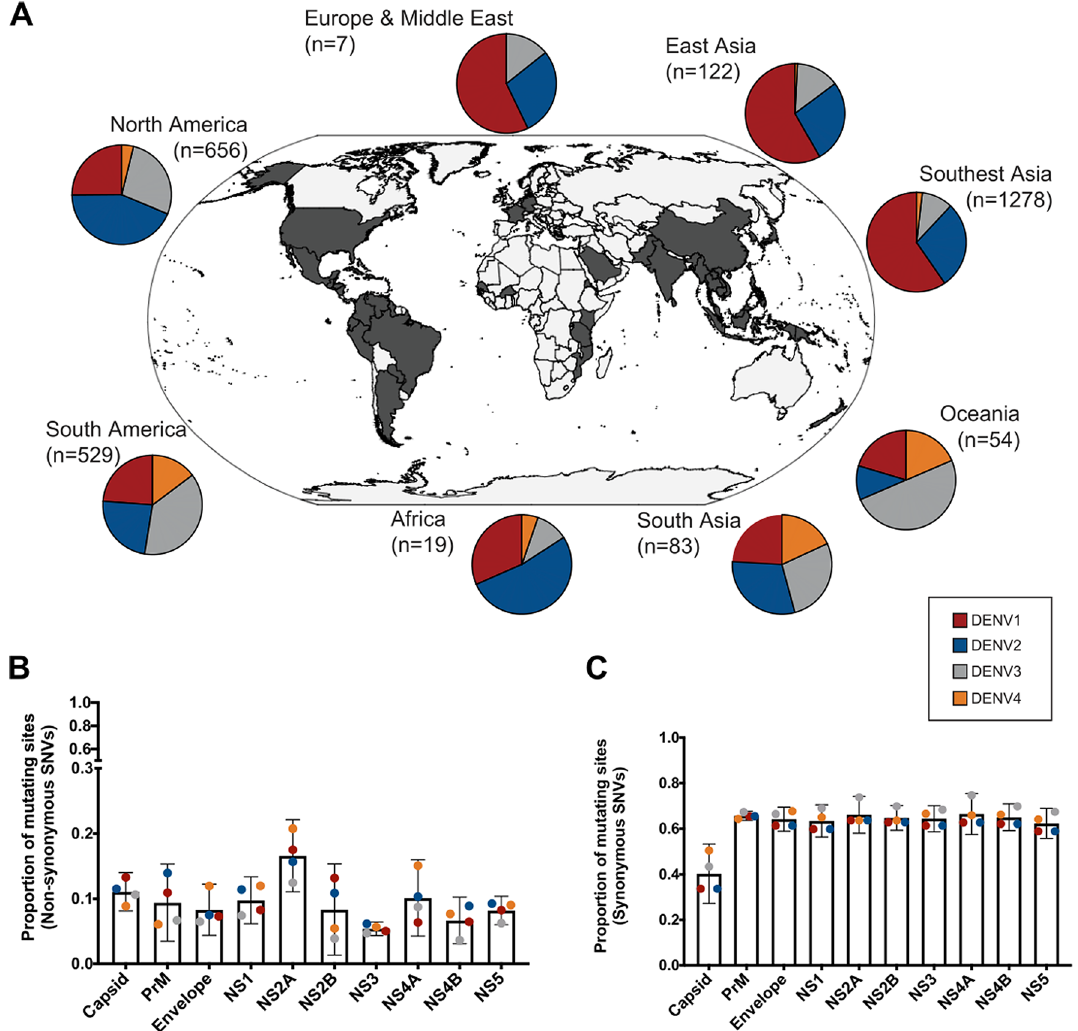
Figure 1. World-wide distribution of DENV serotypes and genomic diversity. ( A ) Geographic distribution of the full-length DENV genome sequences utilised in this study. ( B ) Proportion of mutating sites with non- synonymous ( B ) and synonymous ( C ) SNVs for each serotype and within each sub-genomic